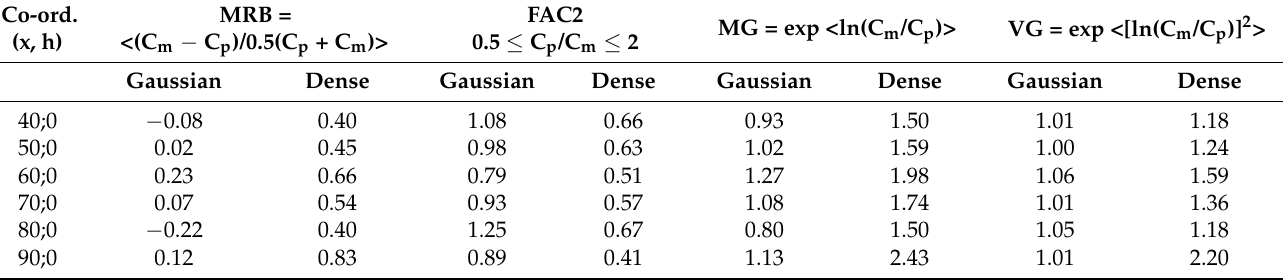
Table 5. Statistical performance measures (SPMs) of the maximum determined theoretical values (C p ) for the dense gas model and Gaussian gas model relative to the maximum recorded gas concentration (C m ) for measurement series 3. Designations: MRB—mean relative bias; FAC2—the fraction of predictions within a factor of two of the measurements; MG—geometric mean bias; VG—geometric variance; red colour—values obtained outside the range of model compliance with the